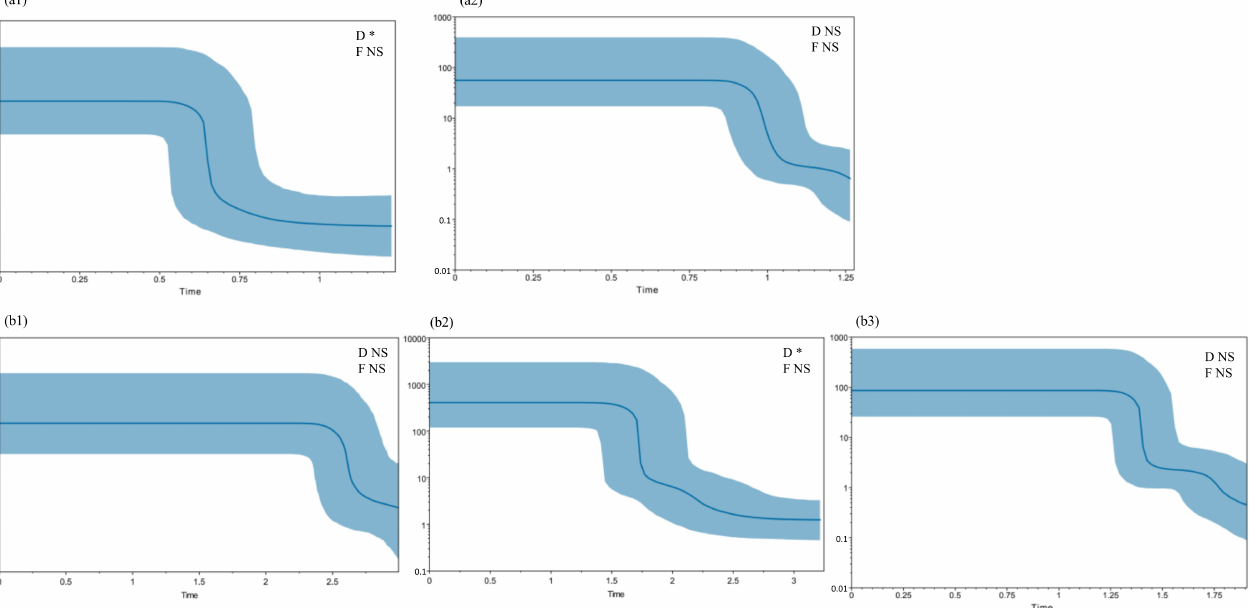
Figure 6. Bayesian skyline plot for each lineage of Pampus chinensis and P . cinereus ; ( a1 ) eastern Indian Ocean lineage of P. chinensis , ( a2 ) western Pacific lineage of P. chinensis , ( b1 ) western Indian Ocean lineage of P . cinereus , ( b2 ) eastern Indian Ocean lineage of P . cinereus , ( b3 ) western Pacific lineage of P . cinereus . The solid line indicates the estimated median population size, and the shaded area indicates 95% HPD intervals. The x -axis represents time in Mya, y -axis represents log effective population size [ log (Ne)]. D and F represent the neutrality test of Tajima’s D and Fu’s Fs , respectively (NS: nonsignificant; *: p < 0.05,